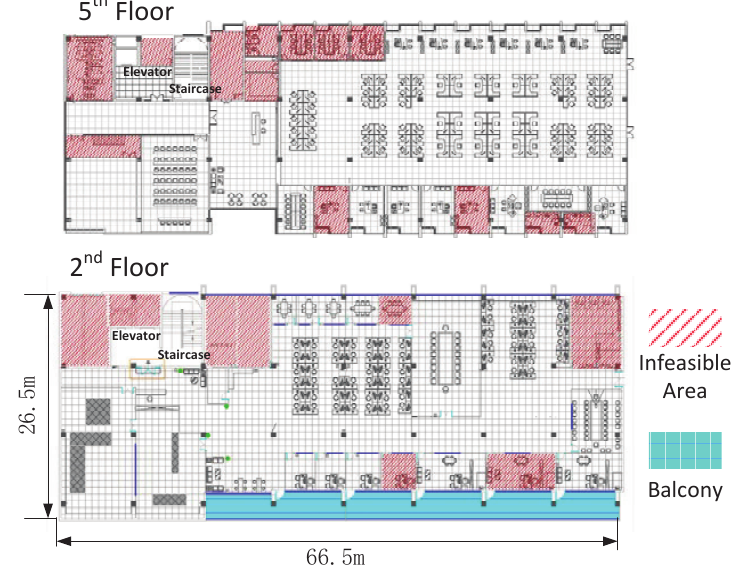
Figure 6. The ground truth of the floor plan for the 5th floor and the 2nd